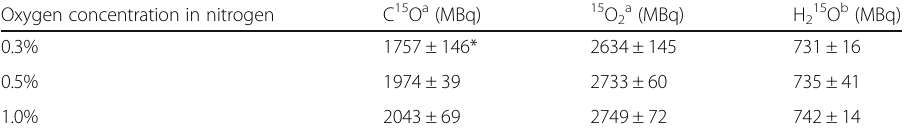
Table 1 Radioactivity yields of C 15 O and 15 O 2 gases and H 215 O saline for three different oxygen concentrations in nitrogen as the target gas Oxygen concentration in